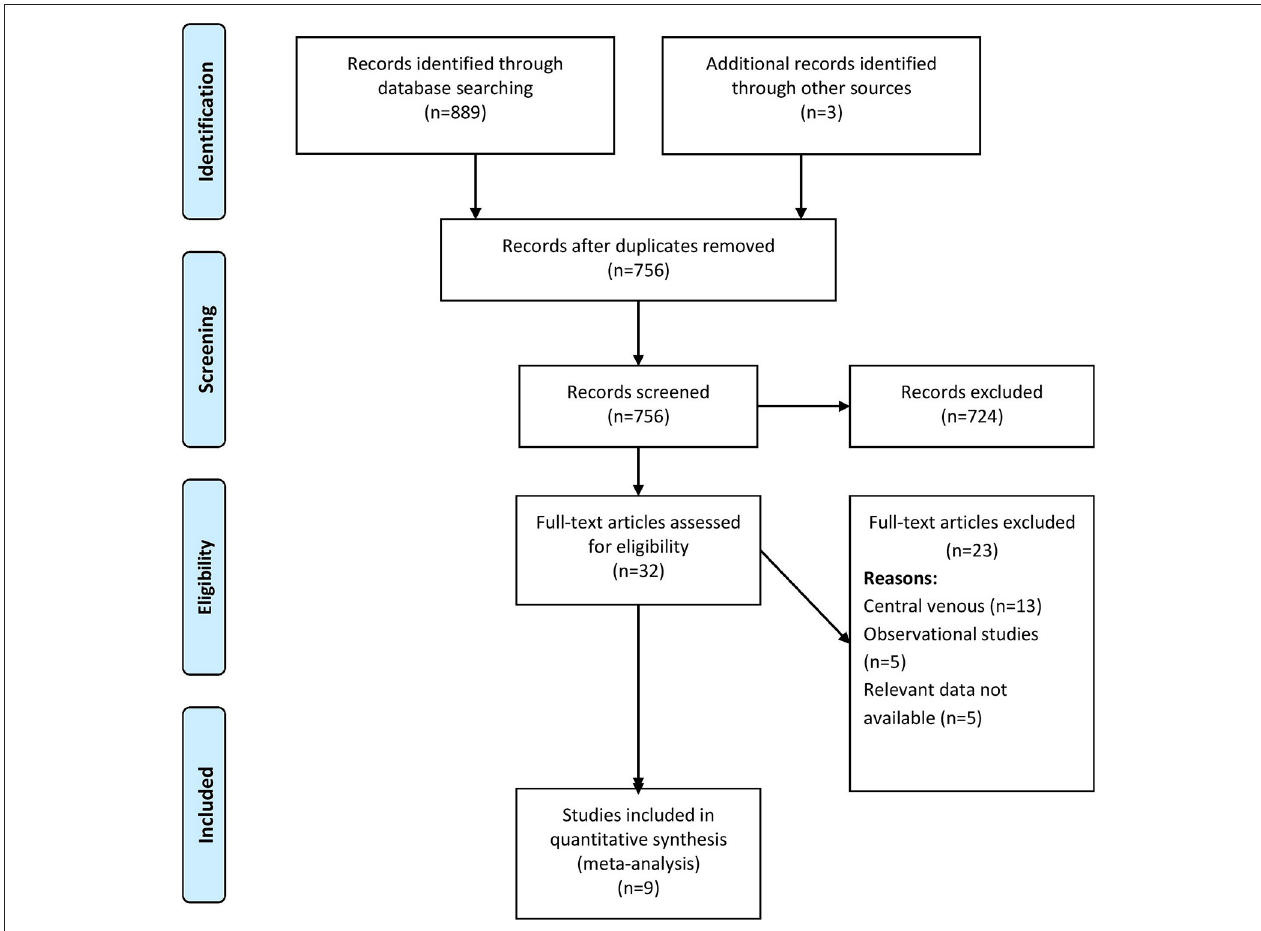
FIGURE 1 | Search